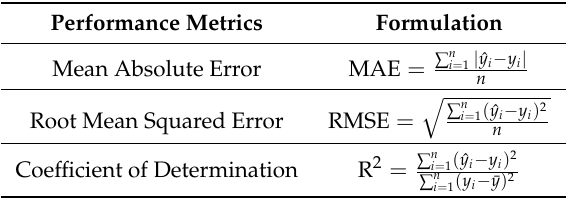
Table 2. The performance metrics used for evaluation of the developed BC proxies. The real measurement value, the mean of the measurement data points, and the predicted proxy value are symbolized by y , ¯ y , and ˆ y , respectively. The notations of i and n are the point number and the total predicted values from the proxies,